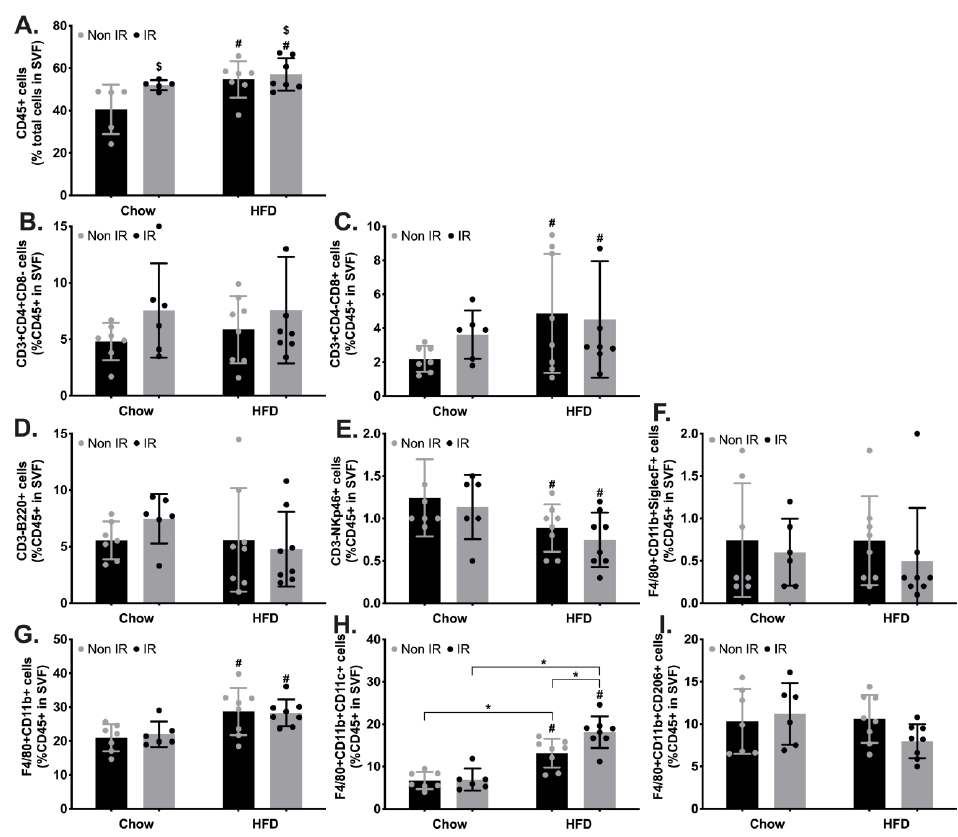
Figure 3. Immune cell profiling in epididymal fat tissue. ( A ). Haematopoietic (CD45+) cells. ( B ). T helper cells (CD45+CD3+CD4+CD8-). ( C ). T cytotoxic cells (CD45+CD3+CD4-CD8+). ( D ). B lympho- cytes (CD45+CD3-B220+). ( E ). Natural killer cells (CD45+CD3-NKp46+). ( F ). Eosinophils (CD45+F4/80+CD11b+SiglecF+). ( G ). Activated macrophages (CD45+F4/80+CD11b+SiglecF-). ( H ). M1 macrophages (CD45+F4/80+CD11b+CD11c+). ( I ). (CD45+F4/80+CD11b+CD206+). $ — irradiation effect; # — high-fat diet effect; * — interaction effect between irradiation (IRR) and high-fat diet (HFD),